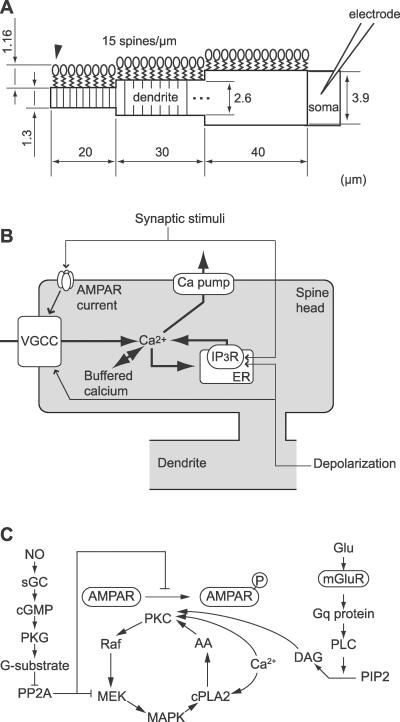
Overview of the Model(A) The electrophysiological structure of the model. Spine necks connect spine heads (arrowhead) to an unbranched dendrite. The right-hand end of the dendrite corresponds to the soma, which is voltage-clamped. Vertical lines indicate compartmentalization of the dendrite.(B) Block diagram of signaling pathways for calcium mobilization in each spine. Thick arrows and thin arrows indicate mobilization of calcium and activation of targets, respectively.(C) Block diagram of AMPAR phosphorylation. Raf is a kinase that phosphorylates and activates MEK. Gq protein is a heterotrimeric guanine nucleotide binding protein that activates PLC. AA, arachidonic acid; DAG, diacylglycerol; PIP2, phosphatidylinositol bisphosphate; PKG, cGMP-dependent protein kinase; PLC, phospholipase C; PP2A, protein phosphatase 2A; sGC, soluble guanylyl cyclase.